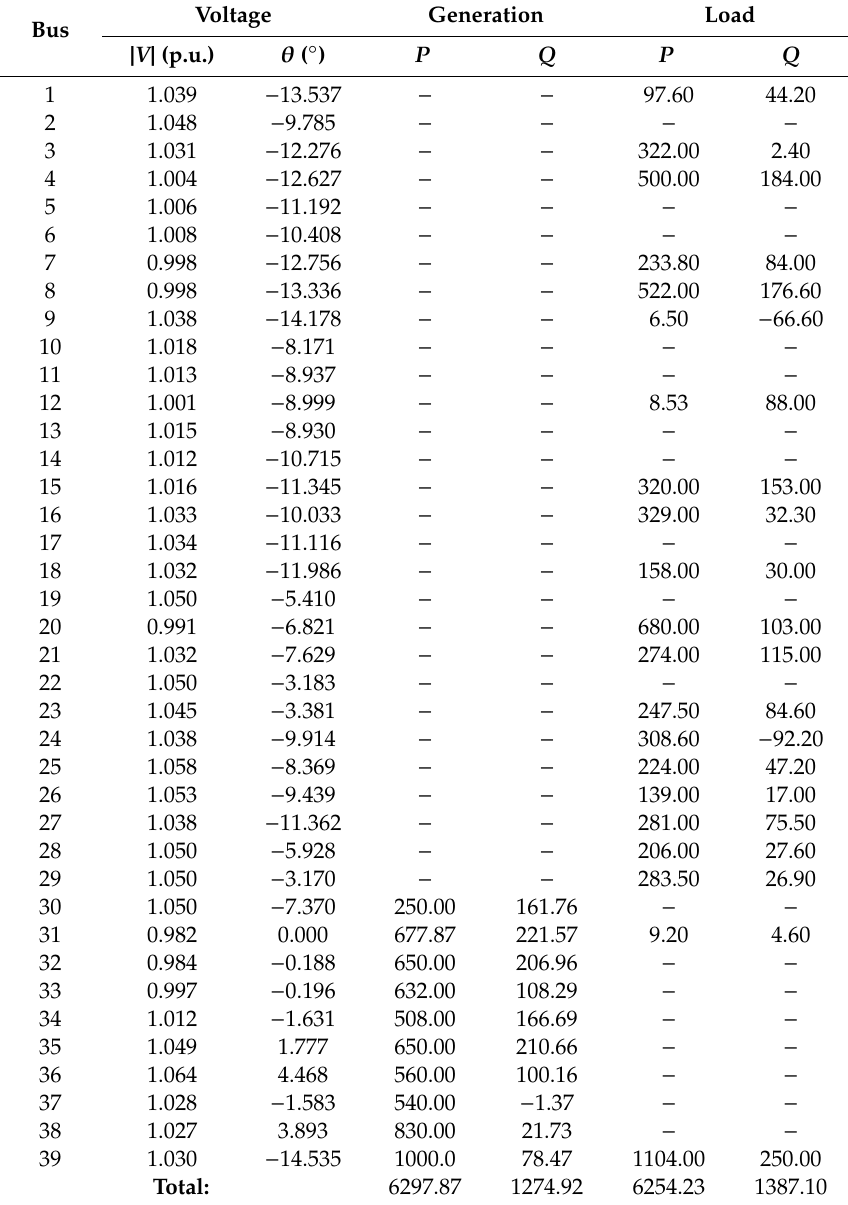
Table A33. Results of AC PF calculations in Case 7-1. AC bus